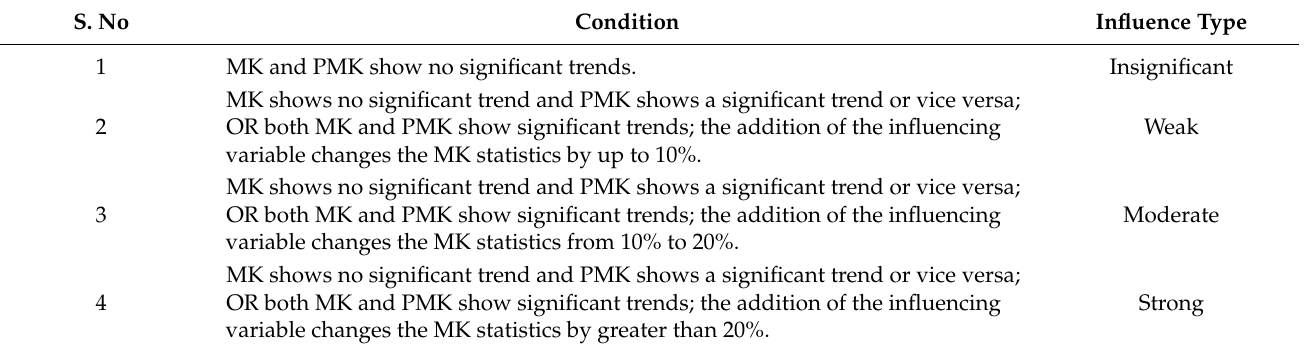
Table 5. Classifications of influence